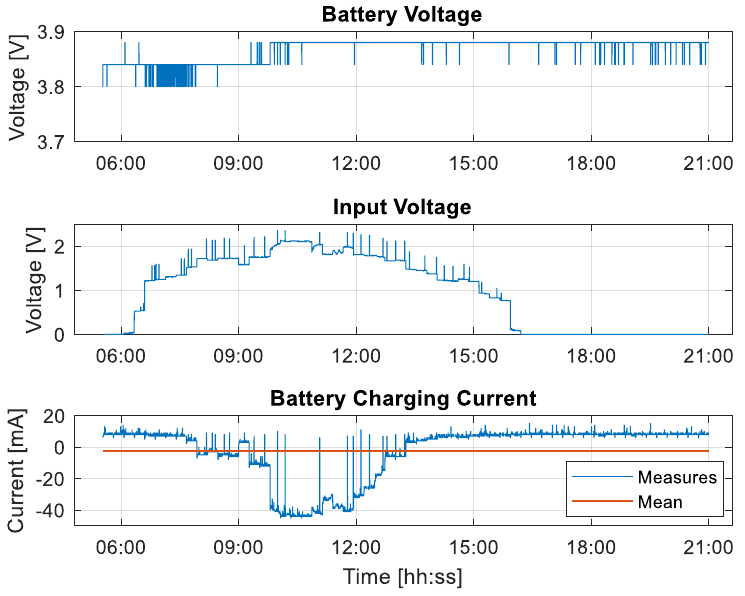
Figure 7. Exemplary acquired data representing the energy harvesting system charging the sensor